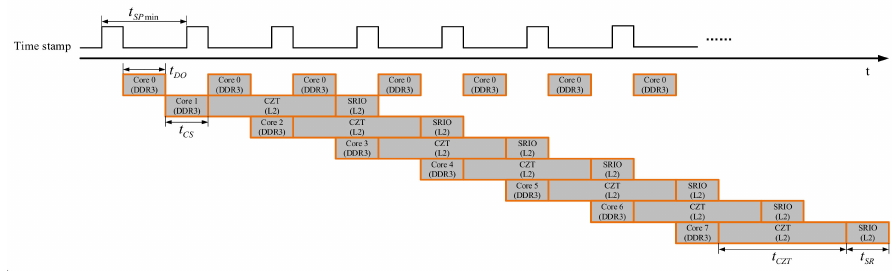
Figure 19. Muti-core pipeline signal processing